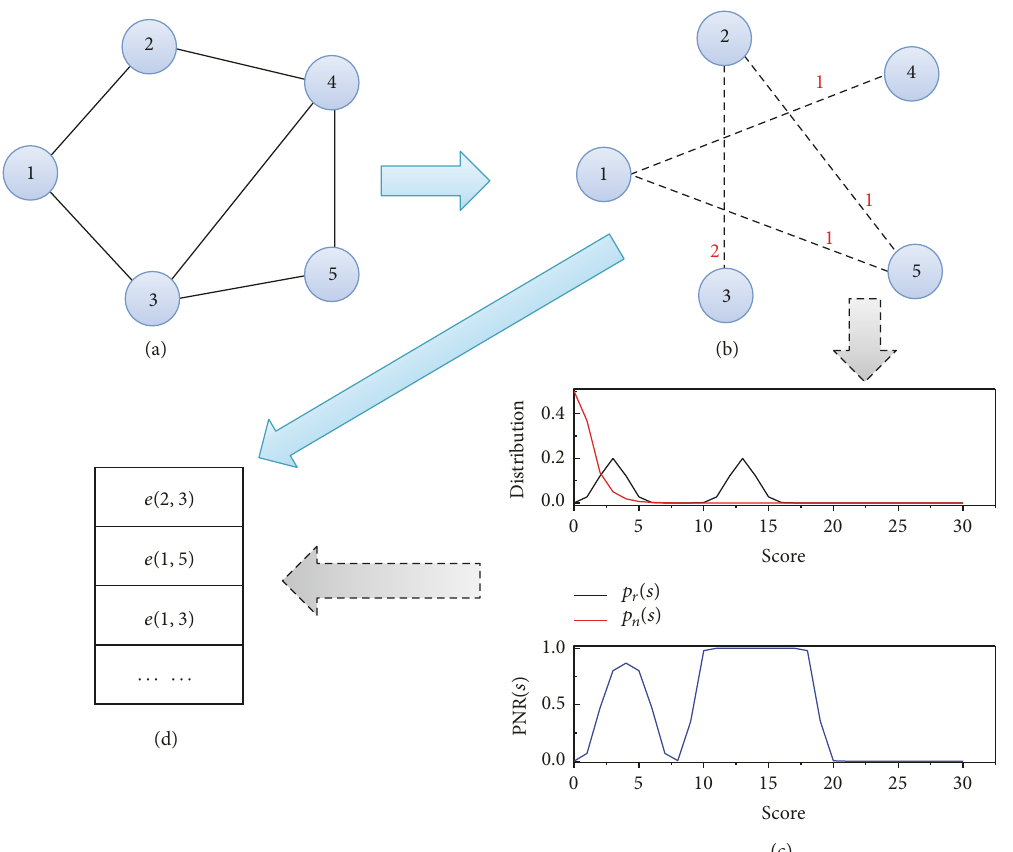
Figure 1: Schematic shows the proposed framework based on CN. (a) A snapshot of a large network. (b) Score of nonexisting links calculated by CN method. (c) The top panel is the score distributions of existing and nonexisting links, 𝑝 𝑟 (𝑠) and 𝑝 𝑛 (𝑠) . The bottom panel is PNR (𝑠) = 𝑝 (𝑠)/𝑝 (𝑠) . (d) Predicted links. State-of-the-art prediction methods follow the path (a) → (b) → (d), while our proposed framework follows 𝑟 𝑛 the path (a) → (b) → (c) → (d), which has an additional path PNR (𝑠)